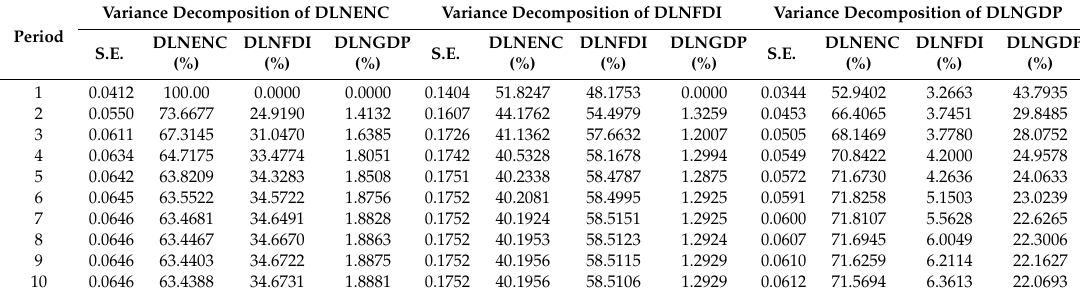
Table 11. Results of variance decomposition of DLNENC, DLNFDI, and